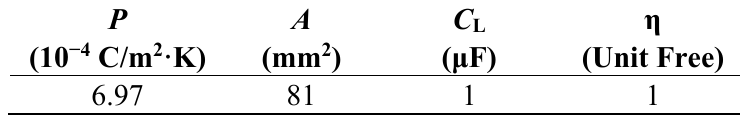
Table 3. Relative conditions for calculating i p , Q , V 0 and E c